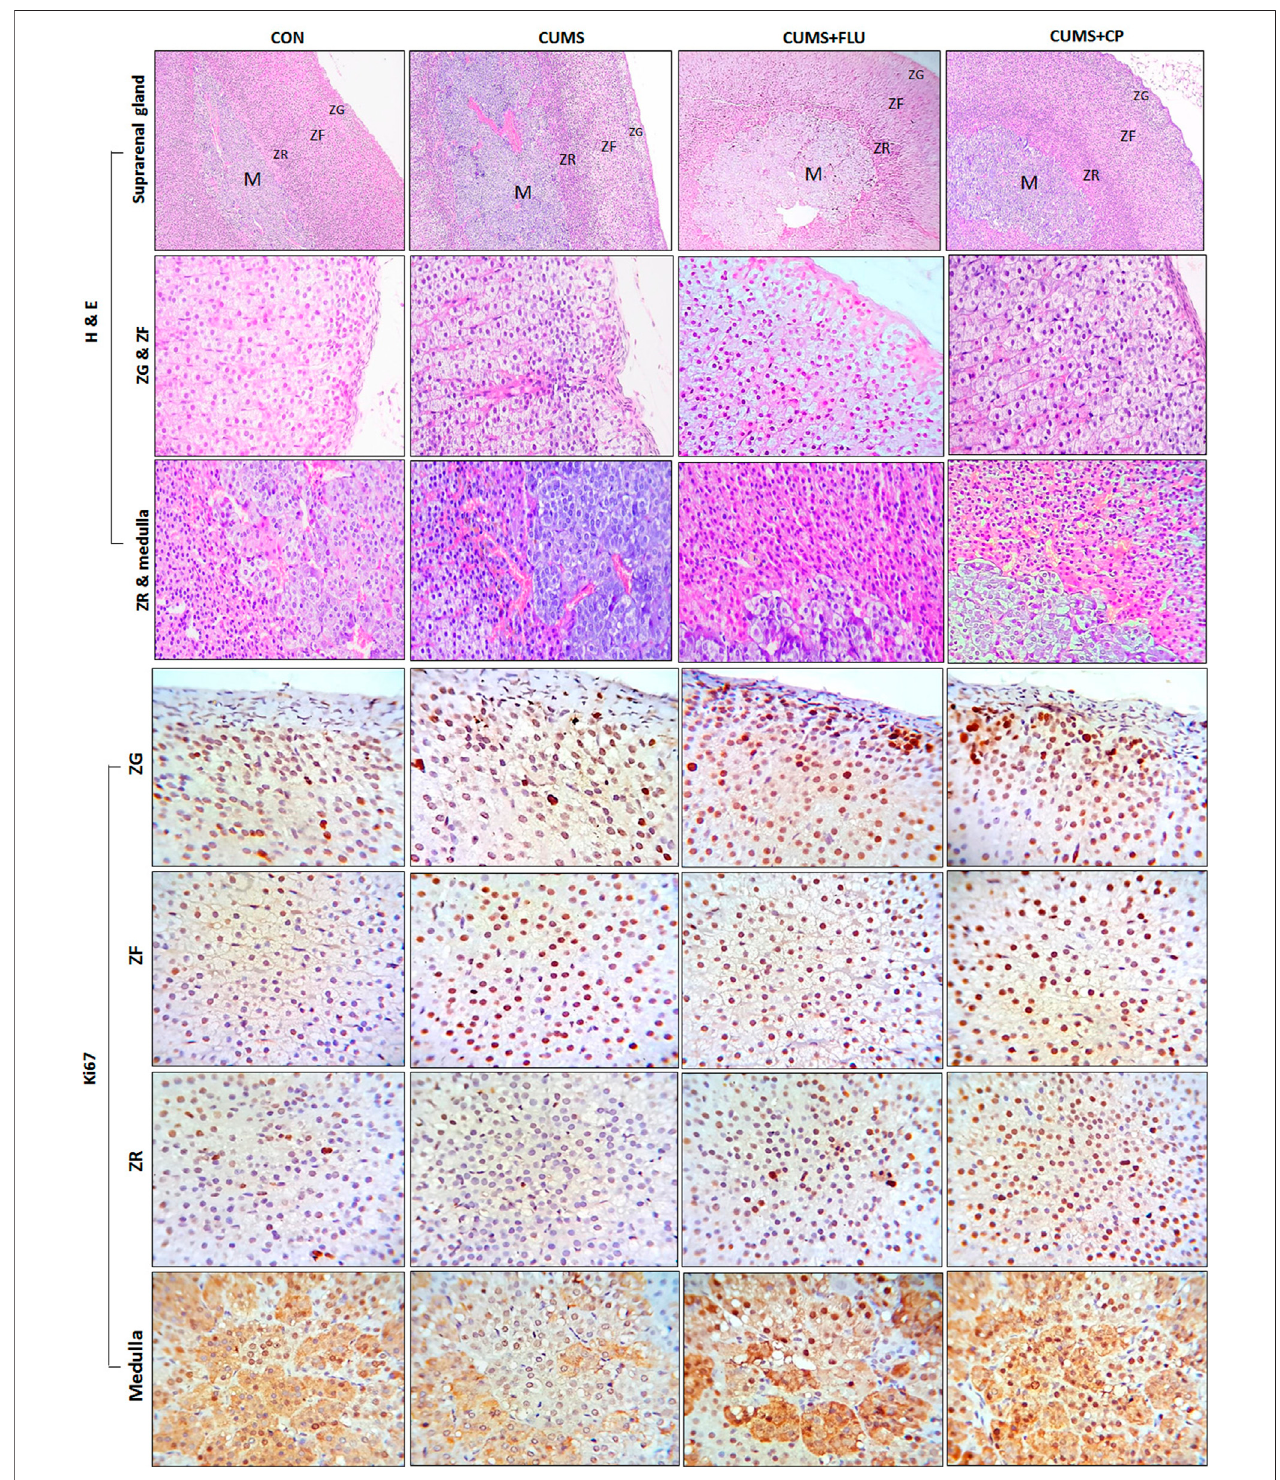
FIGURE4| Sections ofthe adrenal glandofstudied groups stained withH&Estainingand Ki67 antibody(H&E x100and 40,immunohistochemicalstainingX100). ZG, Zona glomerulosa, ZF: Zona fasciculata, ZR: Zona reticularis. CON: control, CUMS: chronic unpredictable mild stress, Flu: fl uoxetine, CP: Cucurbita pepo .